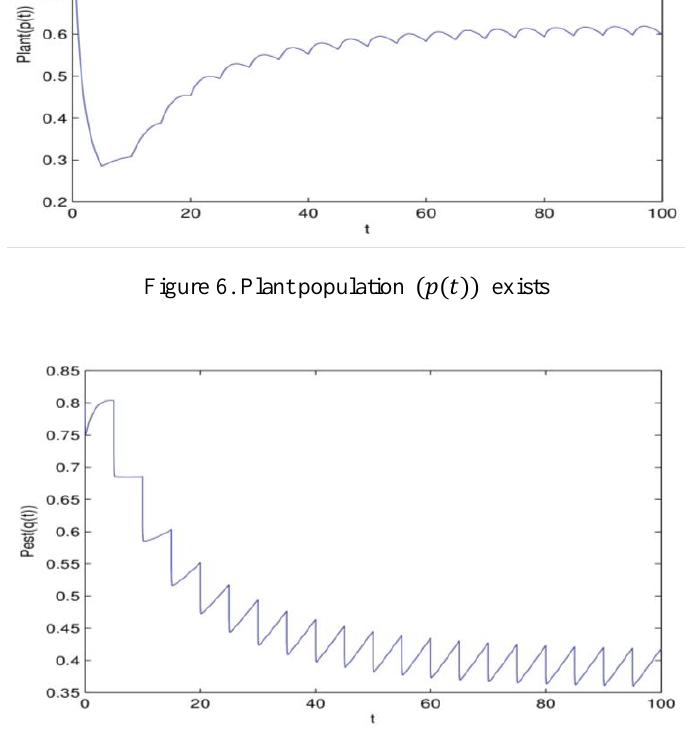
Figure 7. Pest population (𝑞(𝑡))